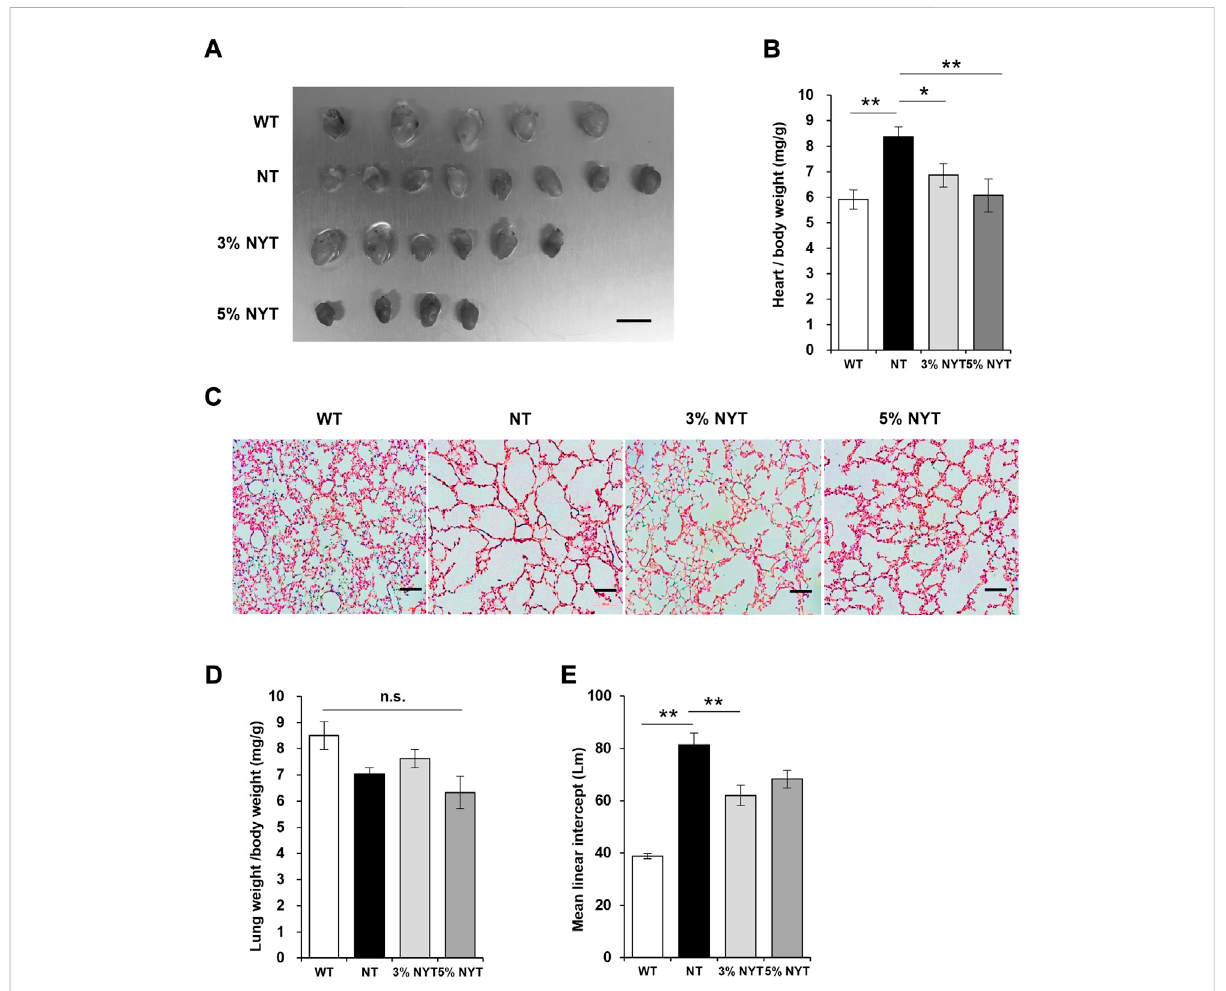
FIGURE 2 Effect of NYT on Heart weight changes and degree of alveolar damage with aging. The dissected heart tissue images (A) on 59 days old and its wet weights (B) are shown, scale bar indicated 7 mm. The wet weights (D) of lung tissue are shown. Histological staining (hematoxylin/eosin) of lung tissuesectionareshownin (C) ,scalebarindicated100 μ m.ThedegreeofalveolardamagewasdeterminedbytheMeanlinearintercept(Lm)method and is shown in (E) . Data are indicated as mean and SEM values. Signi fi cant differences are presented on histograms: [* p < 0.05, ** p < 0.01, Dunnett ’ s contrast, WT ( n = 5), NT (8), 3%NYT (6), 5%NYT